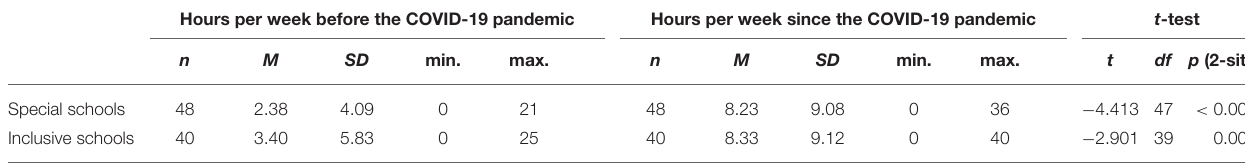
TABLE 5 | Differences between hours of digital learning before the COVID-19 pandemic and since the COVID-19 pandemic regarding school form. Hours per week before the COVID-19 pandemic